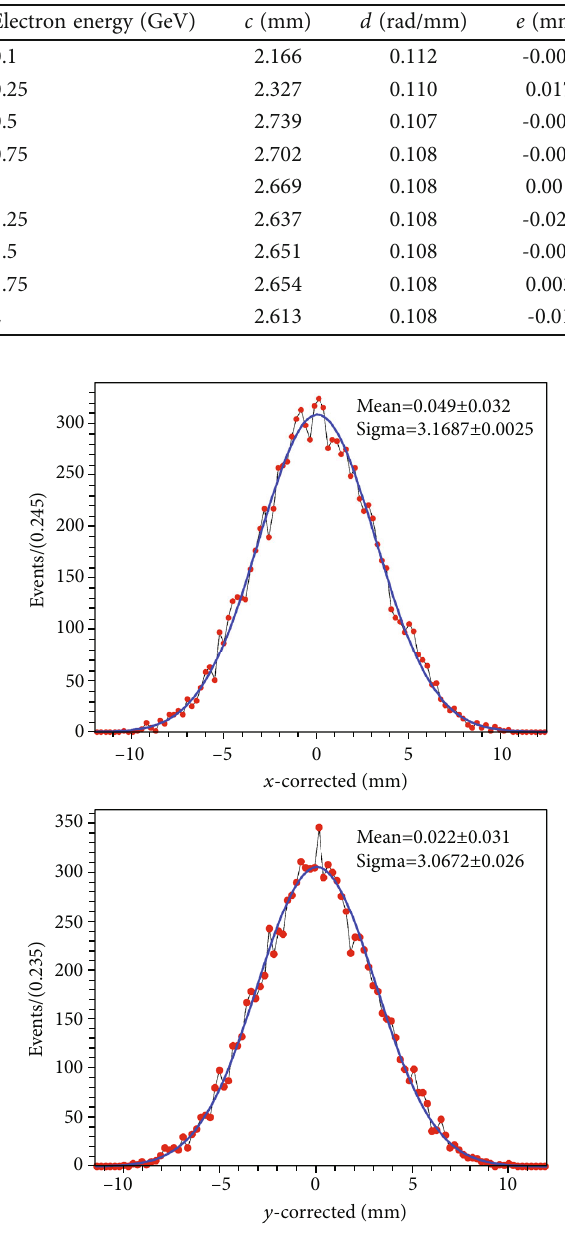
Figure 3: x and y positions after the S-curve corrected corrected correction, for electron energy of 1GeV. Figure 5: Position resolutions in the X and Y directions at the center of the 3 × 3 LYSO matrix as a function of the energy. The solid lines represent the fi ts to the data. The error bars are negligible compared to the symbols shown.